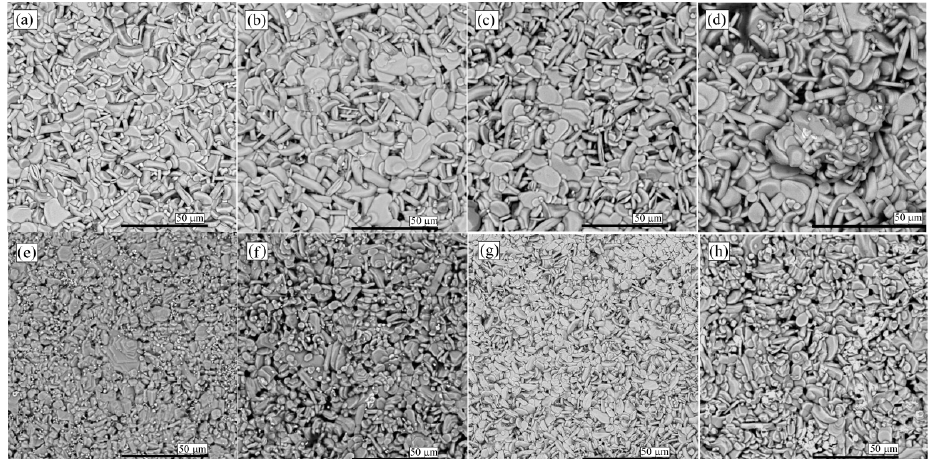
Figure 2. SEM micrographs (BSE mode) from the surface of ( a ) NCO ‐ MASSR, ( b ) NCO1 ‐ MASSR, ( c ) NCO3 ‐ MASSR, ( d ) NCO5 ‐ MASSR, ( e ) NCO ‐ CAC, ( f ) NCO1 ‐ CAC, ( g ) NCO3 ‐ CAC and ( h ) NCO5 ‐ CAC.